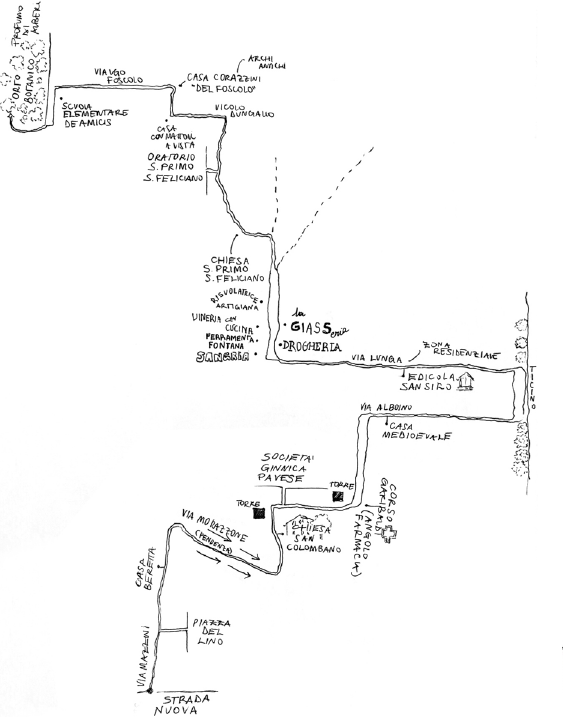
Mental map produced during a psycho-geographi- cal walk in Pavia (image by Anita Beluffi, Maddalena Duse, Linda Migliavacca, Michela Riboni).